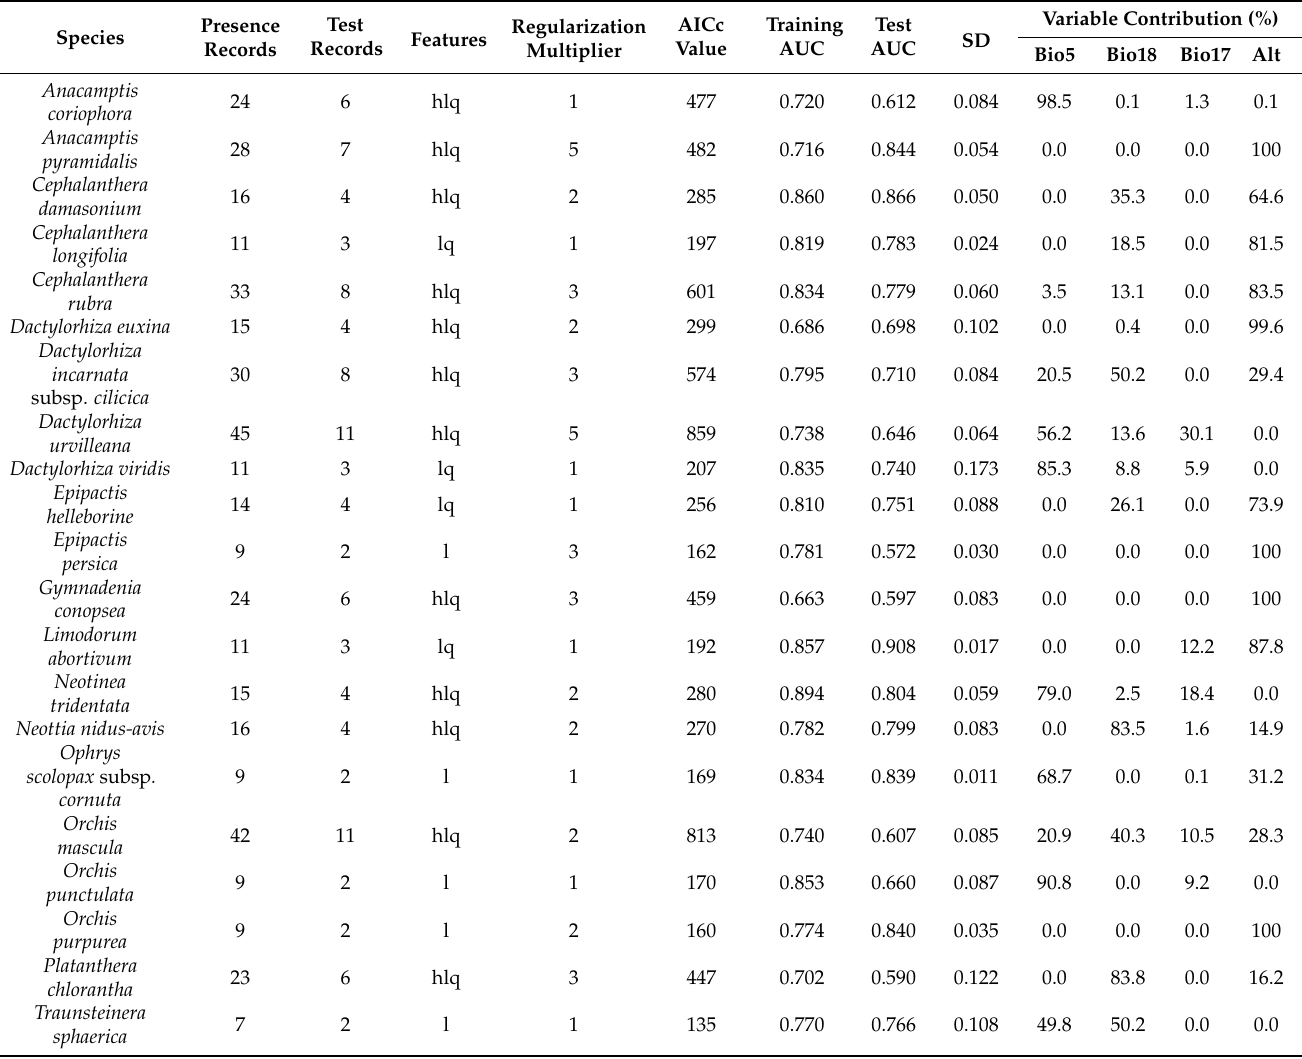
Table 2. Results from MaxEnt species distribution models for orchids in Armenia. The presence records are the number of points used to build each model, while 25% of the data were set aside to be used to test the model (Test records). The features ( l = linear, q = quadratic, h = hinge) and the regularization multiplier used for the best fit model per species are shown. Best-fit model was chosen based on comparing the AICc values of models with regularization multiplier from 1 to 10 for each species (see Table S4: AICc values for model selection using regularization for results). Training and test AUC, with corresponding standard deviation (SD), are also presented, along with the estimate of contributions of the environmental variables (normalized to percentage). Environmental variables were chosen based on a Principal Component Analysis, with max temperature of warmest month (Bio5) corresponding to Principal Component 1 (PC1), precipitation of warmest quarter (Bio18) corresponding to PC2, precipitation of driest quarter (Bio17) corresponding to PC3 and altitude (Alt) corresponding to